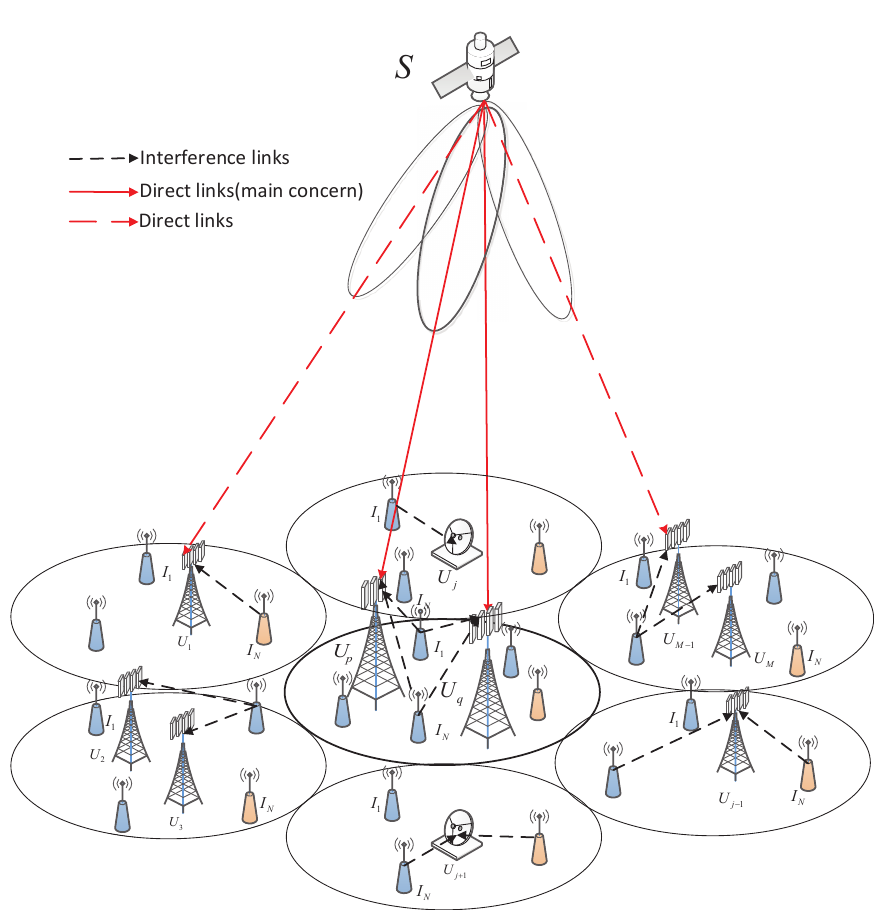
Figure 1. Illustration of a NOMA-based multi-antenna LMS